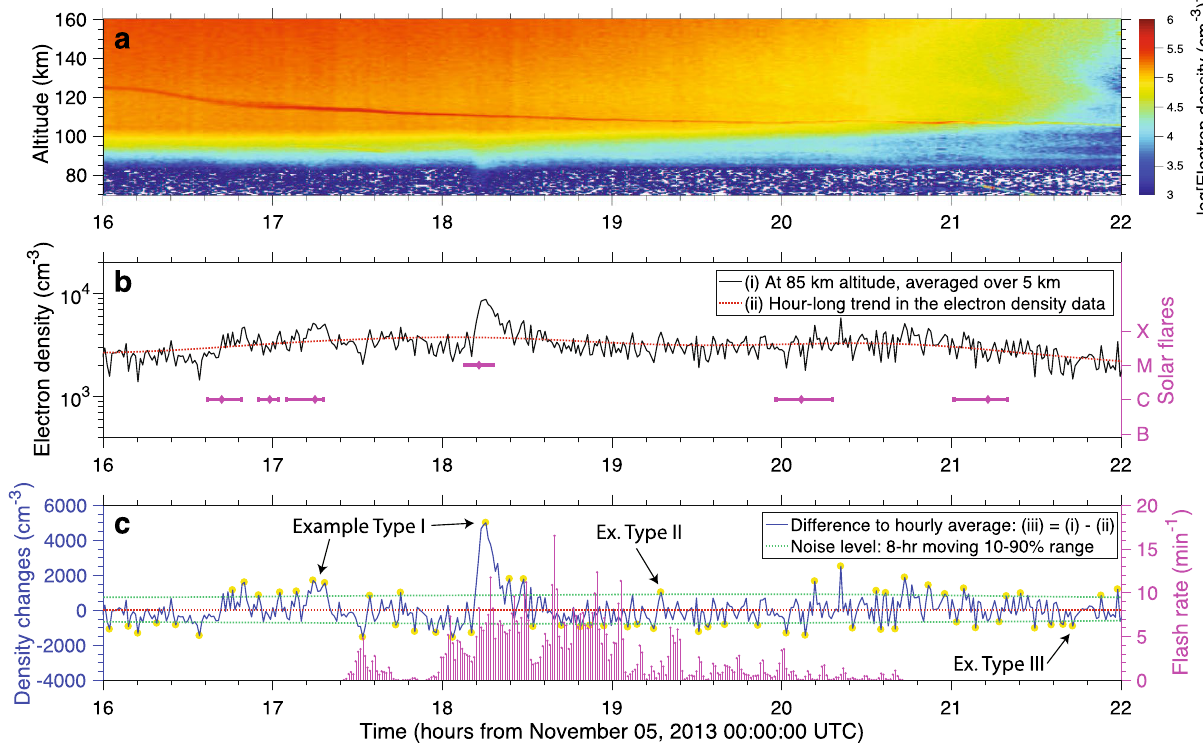
Figure 3. Ionospheric electron density recorded on November 05, 2013. ( a ) Logarithm of electron density data 3 (in cm − ) as a function of altitude (with resolution of 300 m) and time (with resolution of 50 s). ( b ) Electron density time series at 85 km altitude (left-hand-side vertical axis) and solar flare occurrence (duration and category, as shown in the right axis). Curve (i) shows data averaged over a ± 2.5 km altitude range, and curve (ii) shows the data further smoothed with an hour-long moving average. ( c ) Electron density changes (left axis), and flash rate in strikes/min (right axis). Curve (iii) is simply the difference between curves (i) and (ii). Panel ( c ) also shows the noise level (green dashed curve), defined as 10–90 percentile changes in an 8-h-long moving window. The electron density spikes referred to in the text are highlighted with yellow dots. Some examples of the three different types of spikes are labelled with